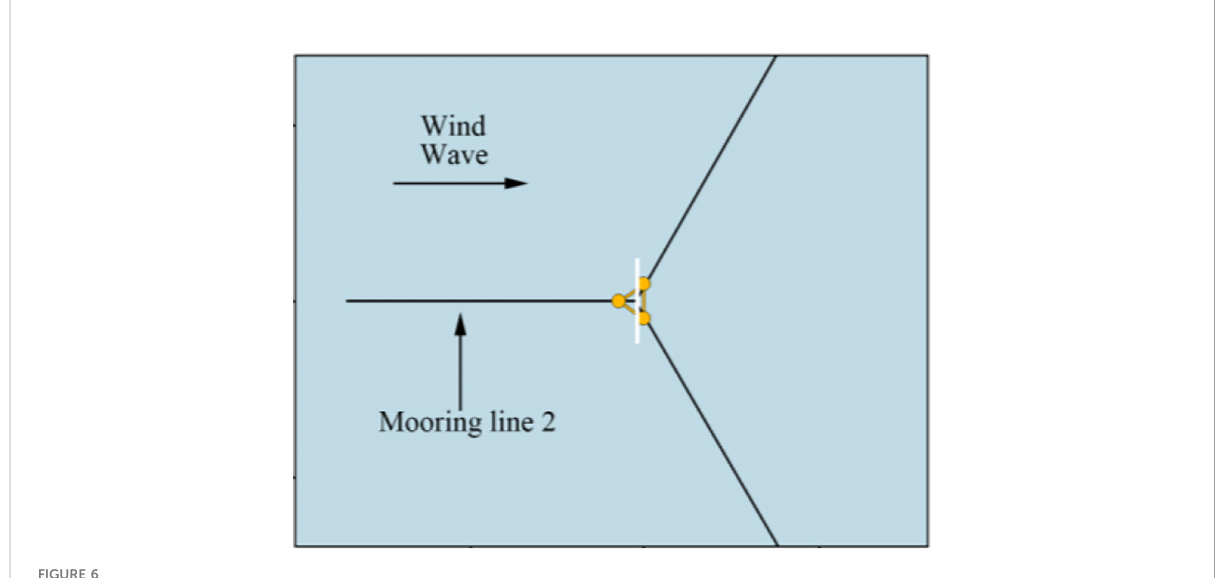
FIGURE 6 Mooring layout for the 5MW semi-submersible